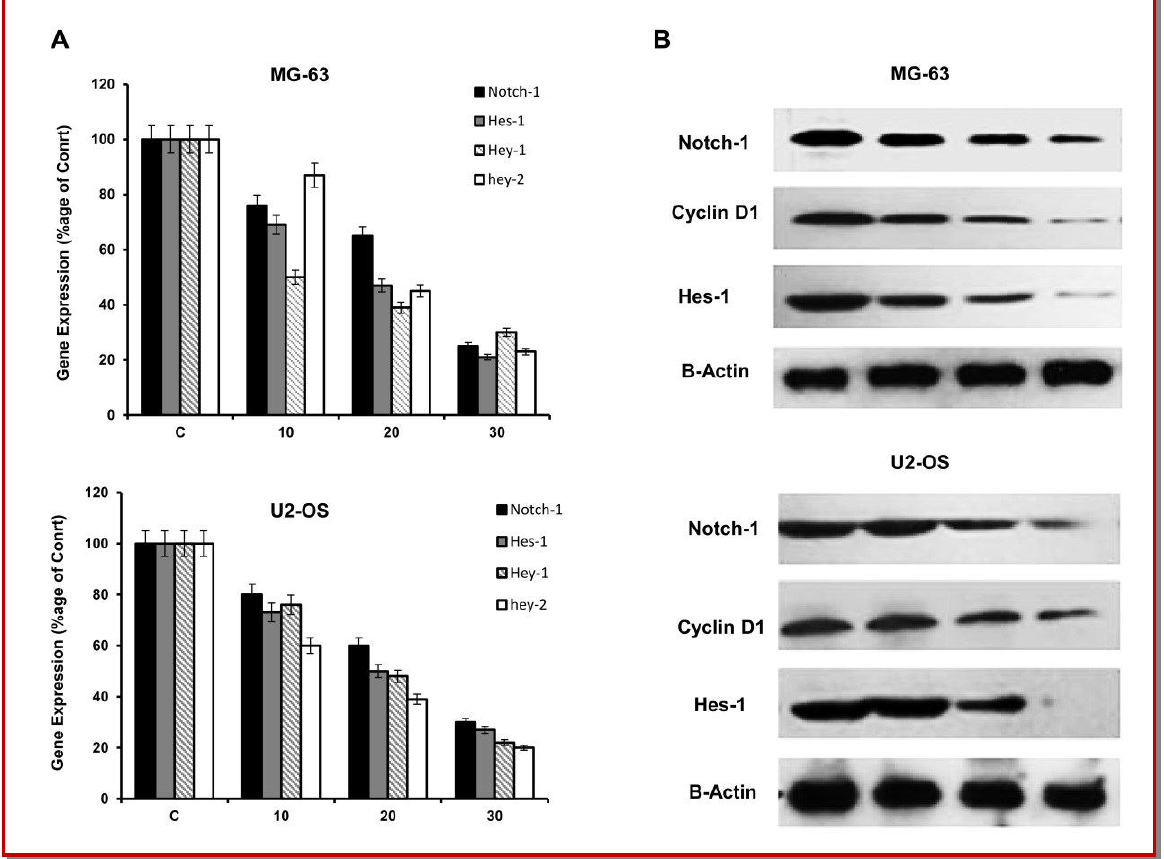
Figure 3: Down-regulation of Notch-1 expression by withaferin A treatment U2OS and MG-63 cells were treated with 10, 20 and 30 µM withaferin A for 48 hours (control: cells treated with dimethylsulfoxide). (A) The mRNA levels in U2OS and MG-63 cells treated with withaferin A were assessed by using real-time RT-PCR analysis. GAPDH was used to normalize the mRNA level. The results are presented as the percentage relative to control. The expression of Notch-1, Hes-1, Hey-1 and Hey-2 genes at the mRNA levels was down-regulated after withaferin A treatment. (B) The protein levels in U2OS and MG-63 cells treated with withaferin A were assessed by western blot analysis. β - Actin was used as a sample loading control. ‘Notch - 1’ indicates the Notch -1 intracellular domain. The expression of Notch-1, Hes-1 and cyclin D1 at the protein levels was down-regulated after withaferin A treatment. Data are expressed as mean ± SD from three independent